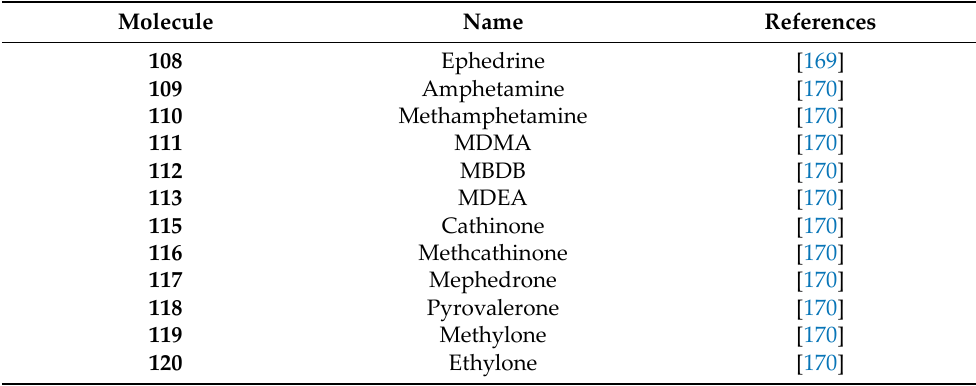
Table 5. Dopamine transporter classical binders.